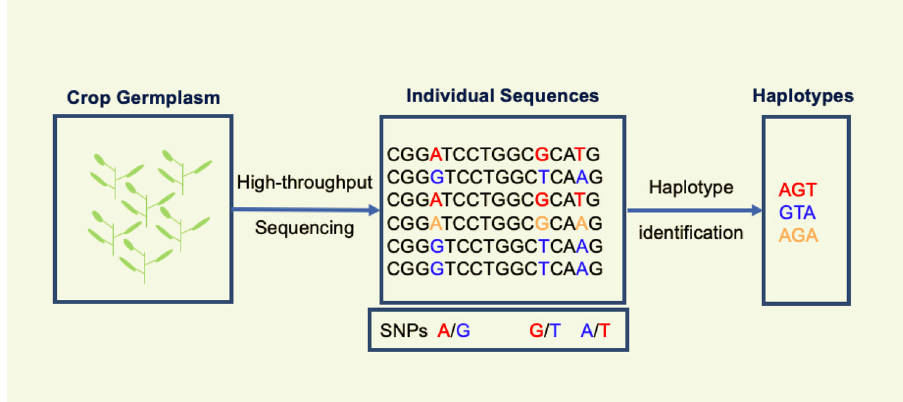
Fig. 1 Formation and development of haplotypes from haploid sequences. Resequencing of the crop germplasm is done to identify the polymorphic SNPs to be subsequently used in the development